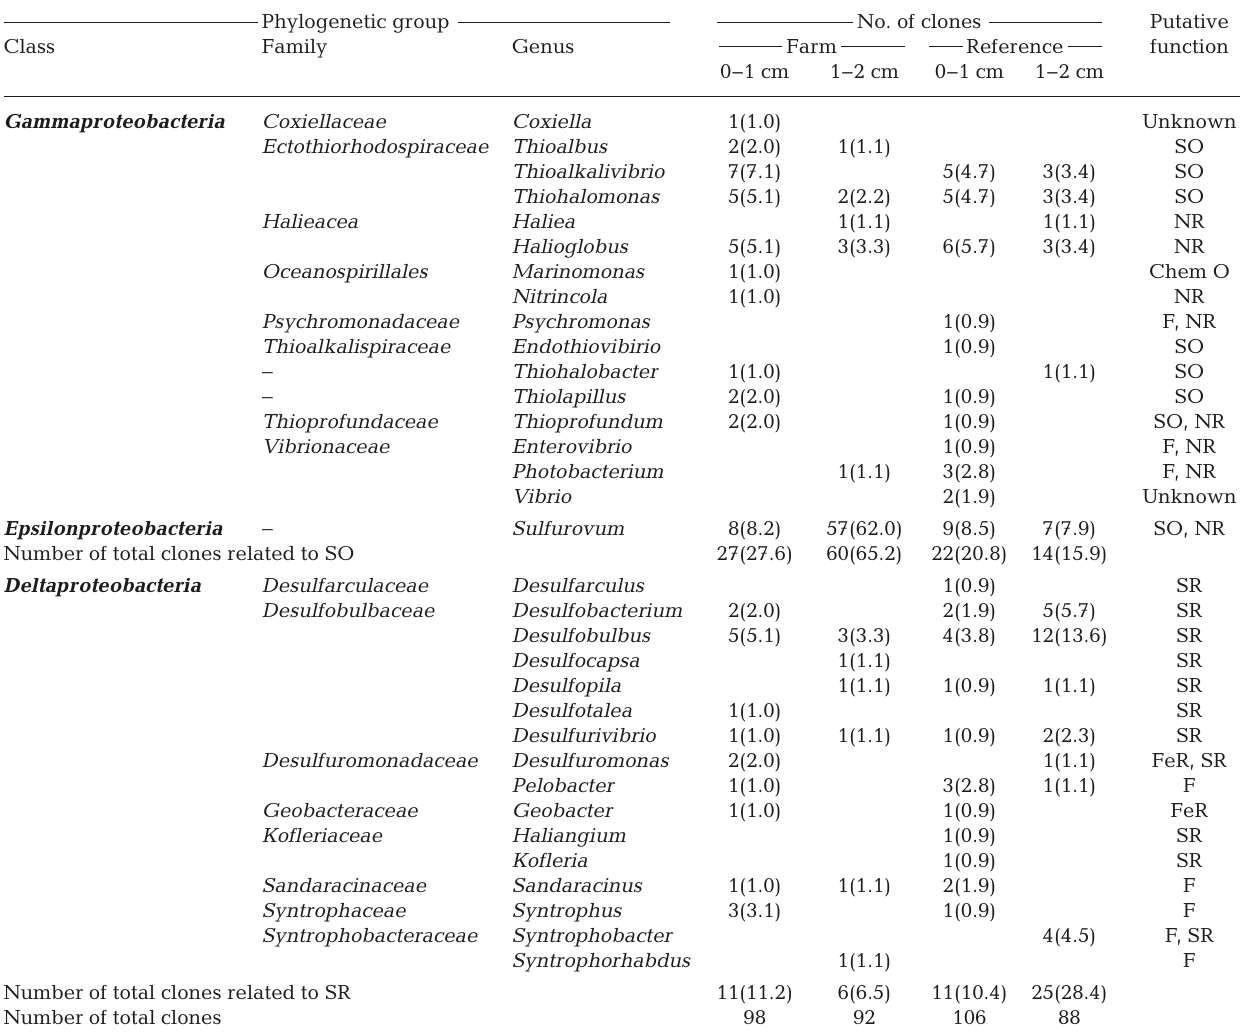
Table 3. Bacterial composition and number of clones closely related to Gamma -, Epsilon - and Deltaproteobacteria found at the farm and reference sites. Numbers in parentheses represent the relative abundance of each clone. The putative function of closely